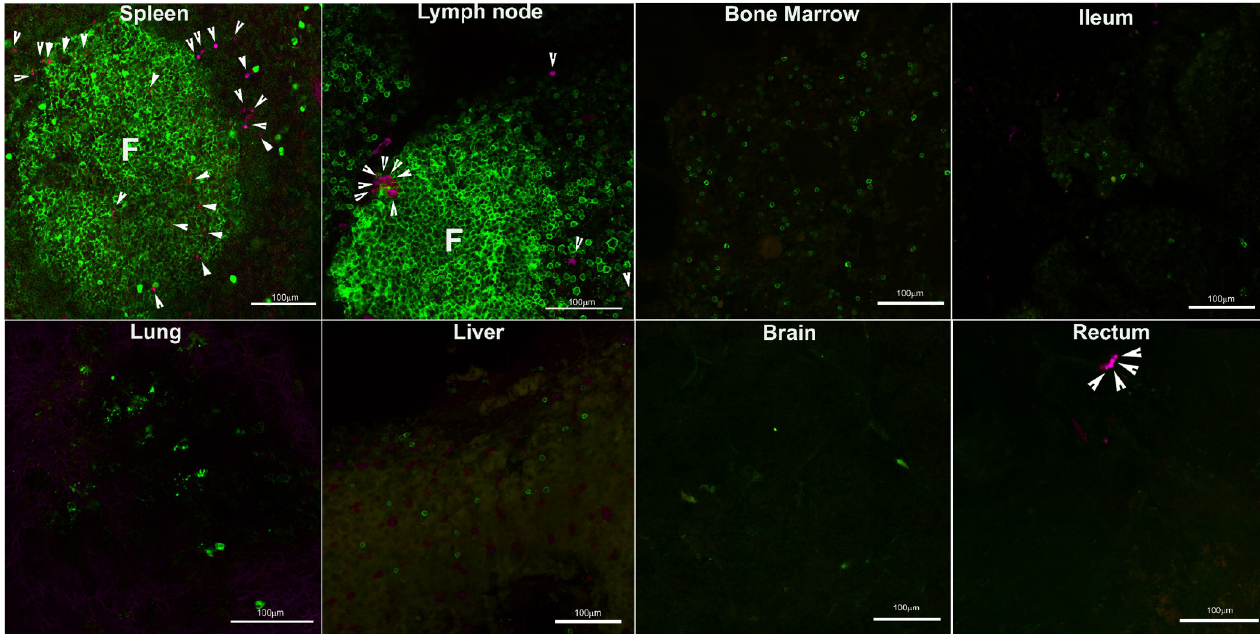
Fig 1. Distribution of CTV-labeled infused T cell product in different tissues at 2 days post-treatment. Location of cell trace violet (CTV)-labeled infused T cells (pseudo-colored magenta) was determined in a chronically SIV-infected ART-na ï ve rhesus macaque, animal R14025 at two days post-treatment (DPT). CTV-labeled infused T cell product was detected in both the follicular and extrafollicular areas of lymphoid tissues. Representative images from spleen, lymph node (LN), bone marrow, ileum, lung, liver, brain, and rectum. Tissues were stained with anti-IgM or anti-CD20 (green) to label B cells and delineate B cell follicles (green). Arrowheads point to CTV-labeled cells. Scale bars = 100 μ m.